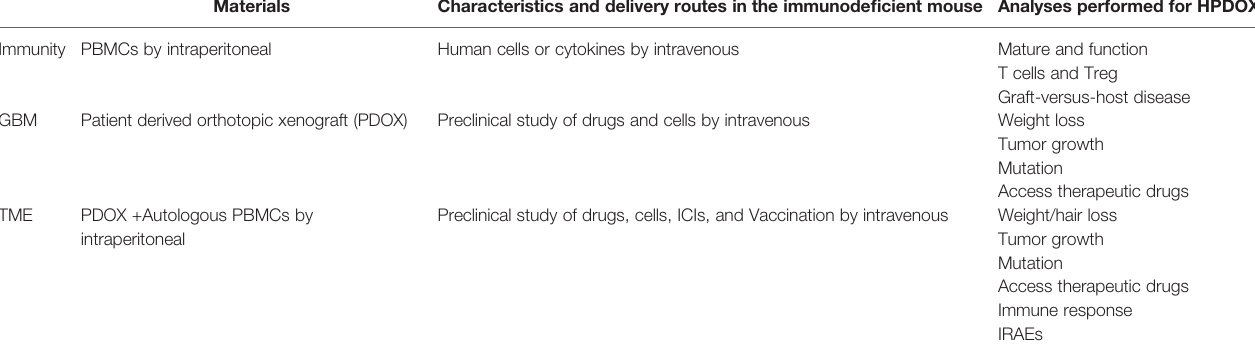
TABLE 2 | Establishing autologous GBM